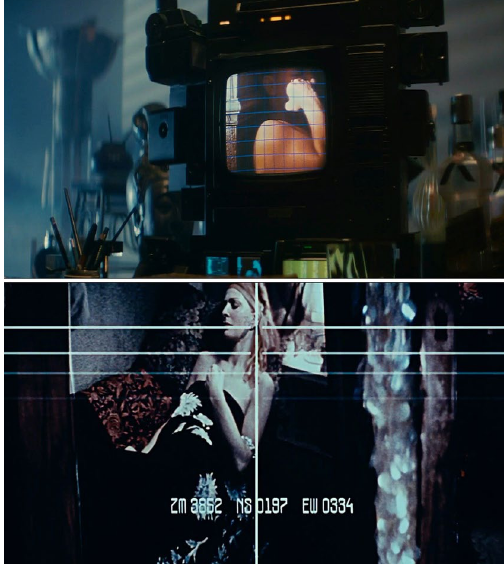
Figure 7 The three-dimension viewer (above) finds a female Replicant behind a male from a still photograph in Blade Runner .